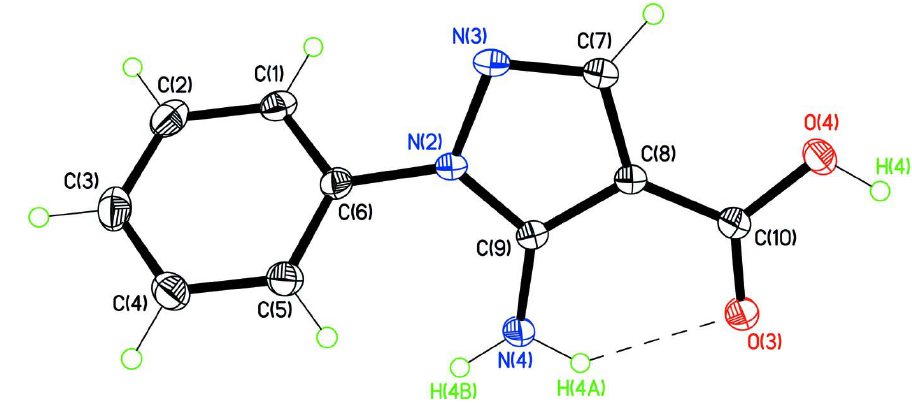
Figure 1 The asymmetric unit of the title compound. Displacement ellipsoids are drawn at the 50% probability level.